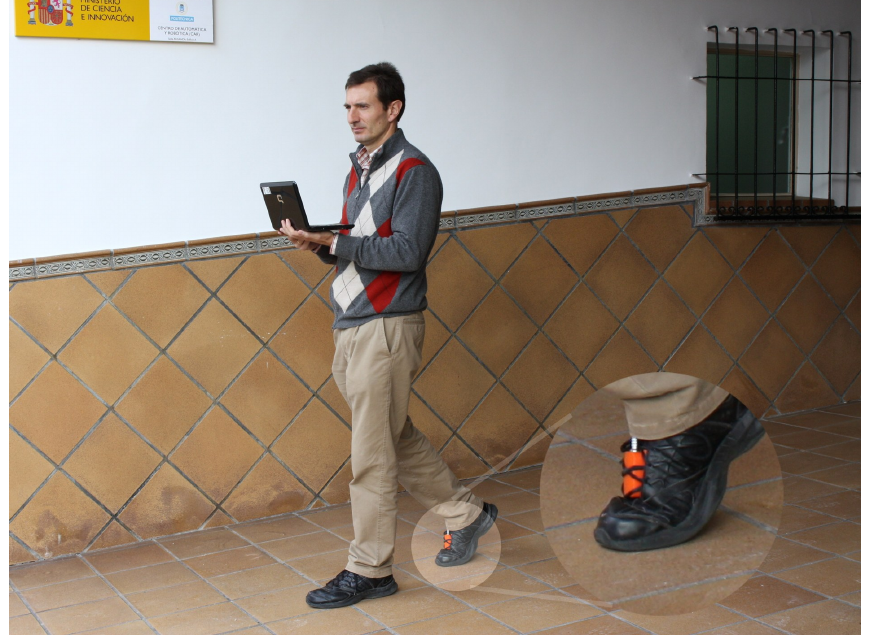
Figure 1. Person walking on one of the access ramps of CAR-CSIC building. For position estimation and ramp detection, an IMU is attached to the right foot of the person using the shoe laces (orange color